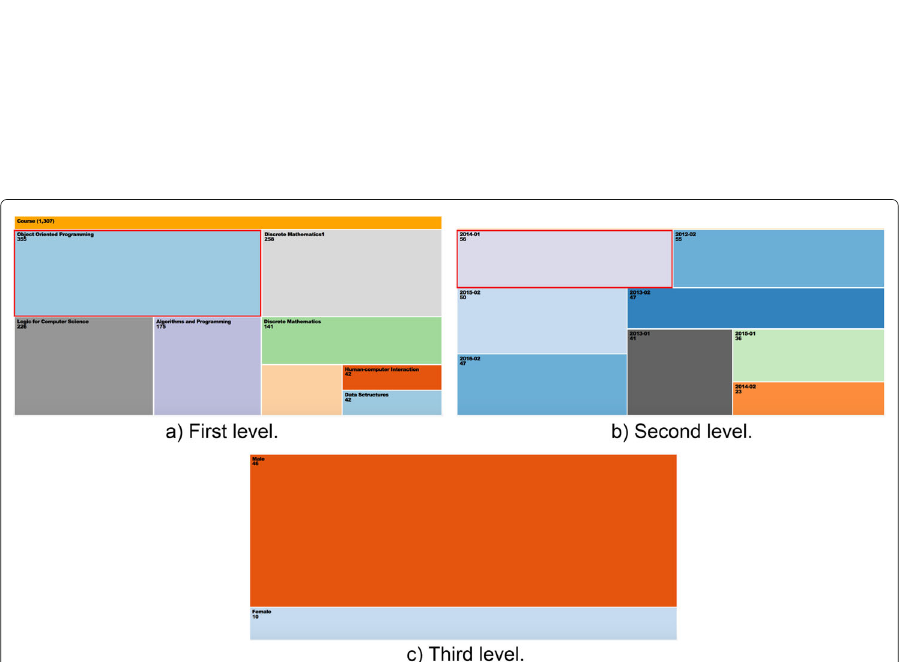
Fig. 5 Treemap visualization for "Object-Oriented Programming"